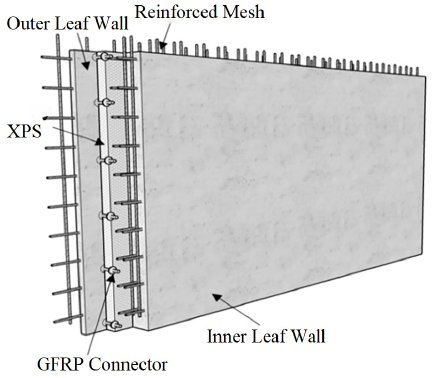
Figure 2. “Structure-Insulation” integrated wall panels construction.